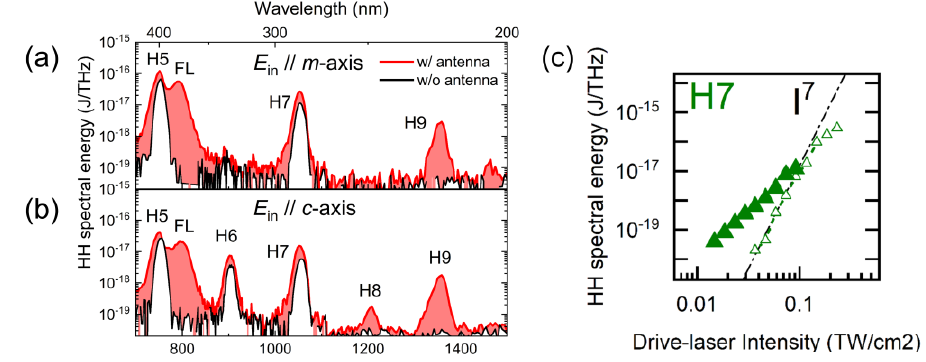
Fig. 2. (a, b) HH spectra measured at input intensity of 0.10 TW/cm 2 for (a) the sample I ( E in // m - axis) and (b) the sample II ( E in // c -axis). The red (black) lines indicate the HH spectra generated from ZnO with (without) antennas. (c) Drive-laser intensity dependence of the 7th harmonic spectral energy, measured for the sample II ( E in // c -axis) with (filled markers) and without (open markers) antennas. The dot-dashed line expresses the multi-photon